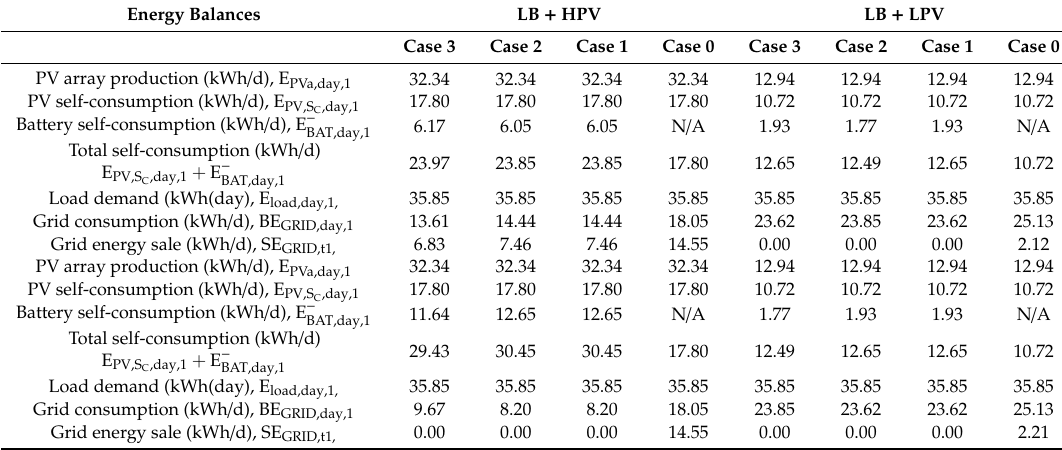
Table 6. Daily energy balances for all scenarios the first